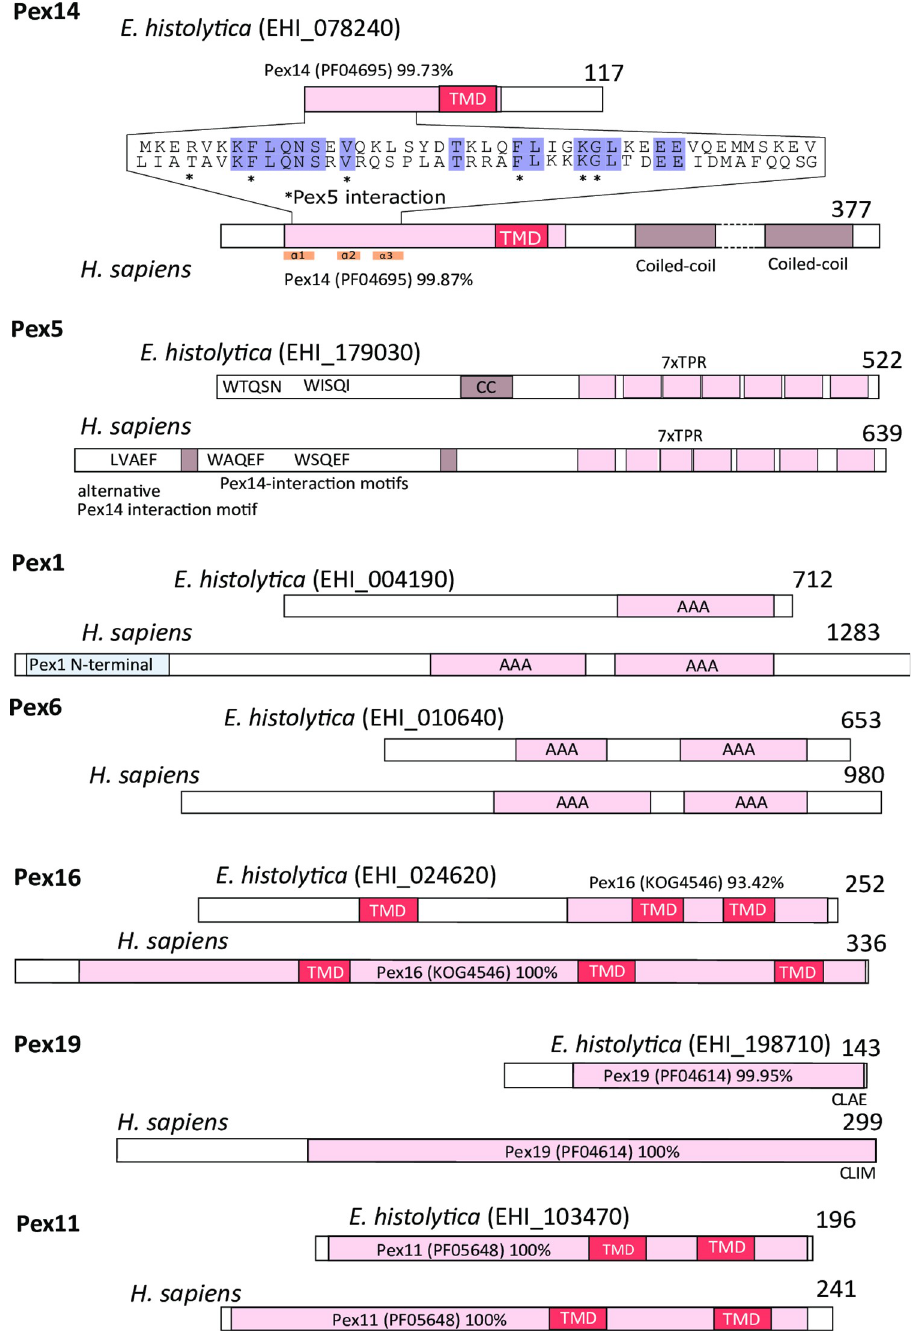
Fig 2. Domain structures of E . histolytica and Homo sapiens PEXs. PFAM domain identifiers (in brackets) and probability percentages are indicated. TMD, transmembrane domain; TPR, tetratricopeptide domain; stars indicate Pex14 amino acid residues that are involved in Pex5 interactions